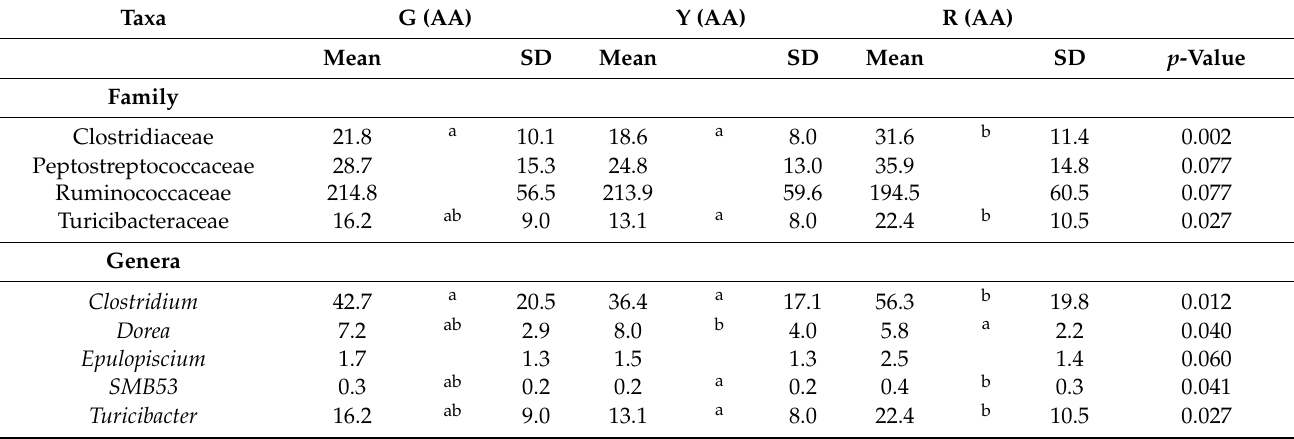
Table 2. Statistical comparison of the mean abundances of bacteria at a family and genus taxonomic levels measured in feces sampled from lactating cows classified as healthy (G), at risk (Y) and with subclinical mastitis (R) on the basis of total somatic cell count (SCC) and differential somatic cell count (DSCC). Only taxa which significantly differed with the Kruskal–Wallis non-parametric test are